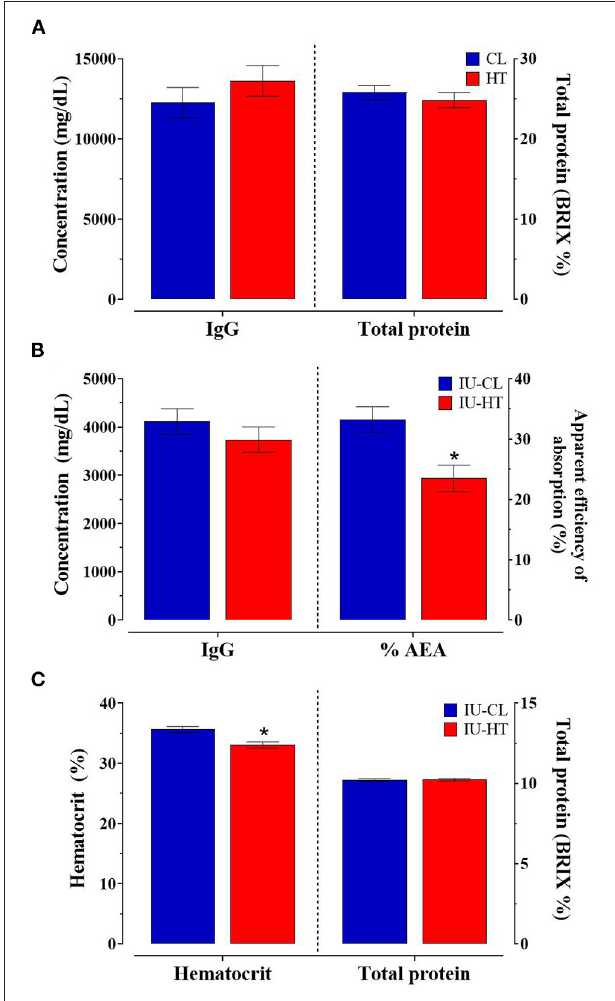
FIGURE 4 | Colostrum and blood parameters of a subset of heifers exposed to late-gestation in utero heat stress (IU-HT, red bars, n = 15) or cooling (IU-CL, blue bars, n = 15). (A) Colostrum total IgG and total protein (TP) concentration (0.8h after birth) and (B) serum IgG concentration and apparent efficiency of absorption (% AEA) 24-h after colostrum consumption. (C) Whole blood hematocrit and serum TP of heifers from 0 to 63 d of age, collected between 13 and 15 h. Data is presented as LSM ± SE for the main effect of in utero treatment. *Indicates significance ( P ≤